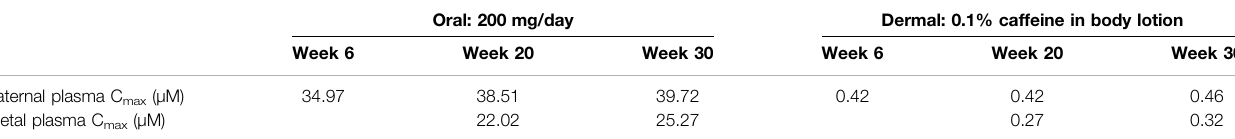
TABLE 3 | Summary of the predicted maternal and foetal plasma C max of caffeine at steady state through different gestational ages from both oral and dermal exposure